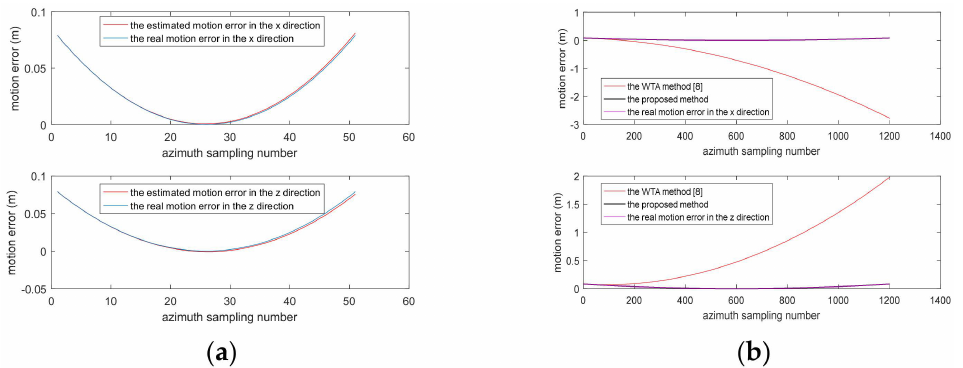
Figure 11. ( a ) Motion error estimation results when p = 24 (simulation experiments); ( b ) The comparative results of WTA and the proposed method.